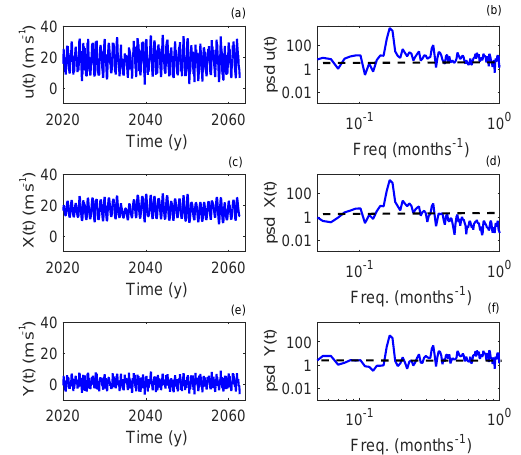
Figure 1. Example of wavelet filtering. (a) u 500 monthly time se- Figure1. Exampleofwaveletfiltering.a) u 500 monthlytimeseriesatLon=78WandLat=38Nandb)correspondingpowerspectraldensity ries at 78 ◦ W, 38 ◦ N and (b) corresponding power spectral density (psd).c)Timeseriesofthecoherentcomponent X ( t ) extractedbythewaveletfilterandd)itspsd.e)Timeseriesofthenoisycomponent (psd). (c) Time series of the coherent component X ( t ) extracted by Y ( t ) extractedbythewaveletfilterandf)itspsd. the wavelet filter and (d) its psd. (e) Time series of the noisy com- ponent Y ( t ) extracted by the wavelet filter and (f) its